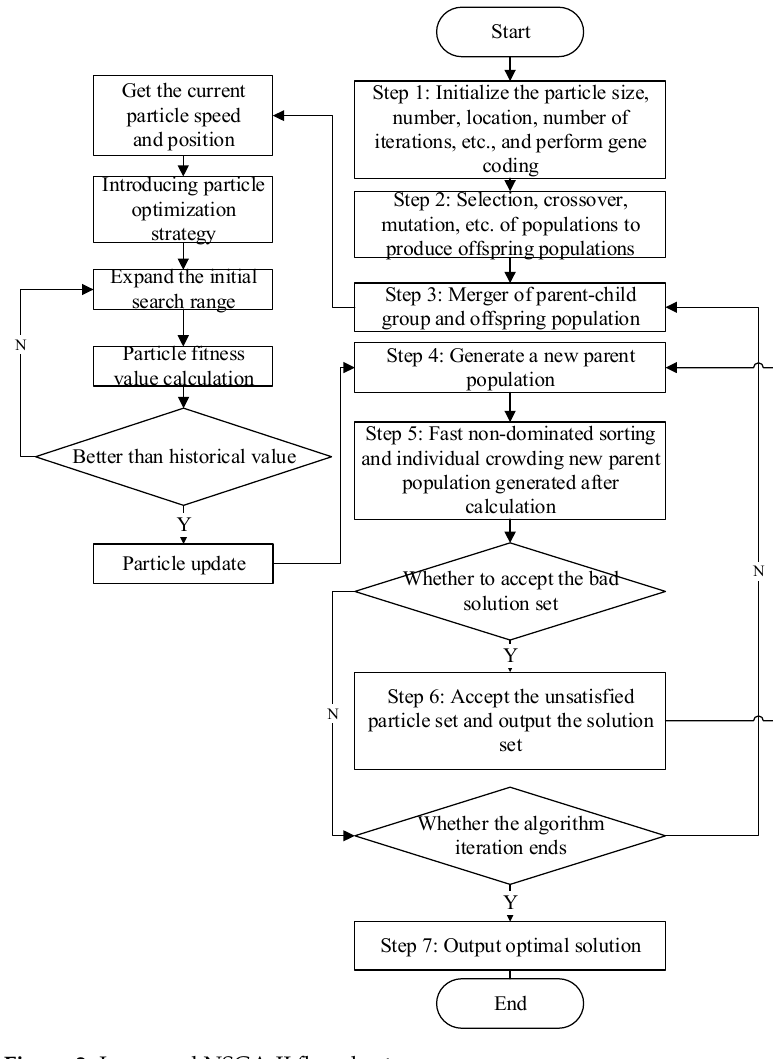
Figure 2. Improved NSGA-II flowchart.